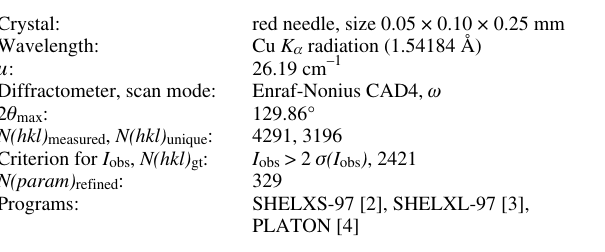
Table 1. Data collection and handling.